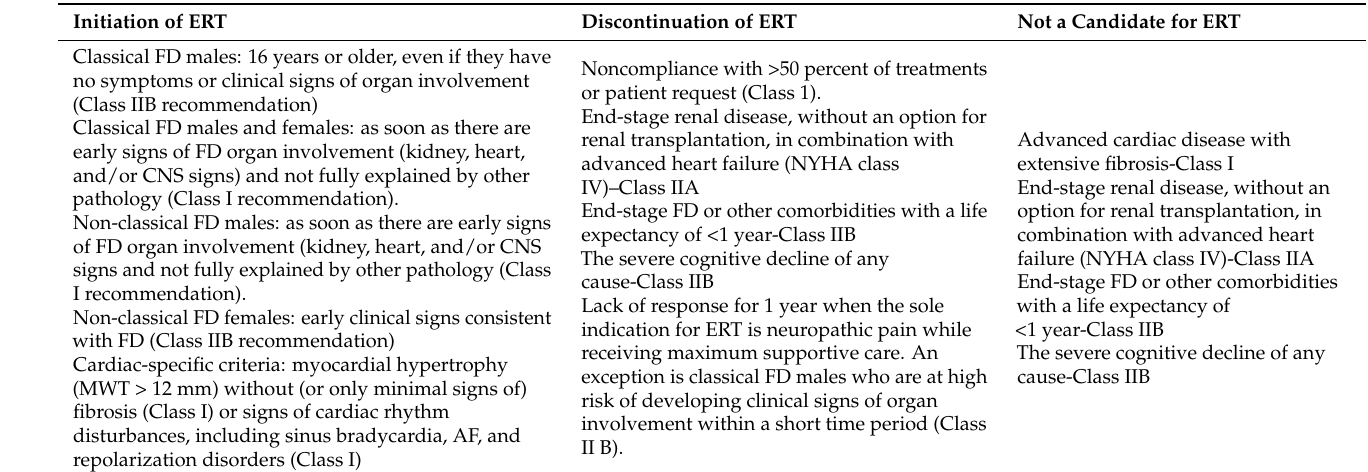
Table 3. The European Fabry working group consensus document [46] recommendations for enzyme replacement therapy. enzyme replacement therapy (ERT), New York heart association